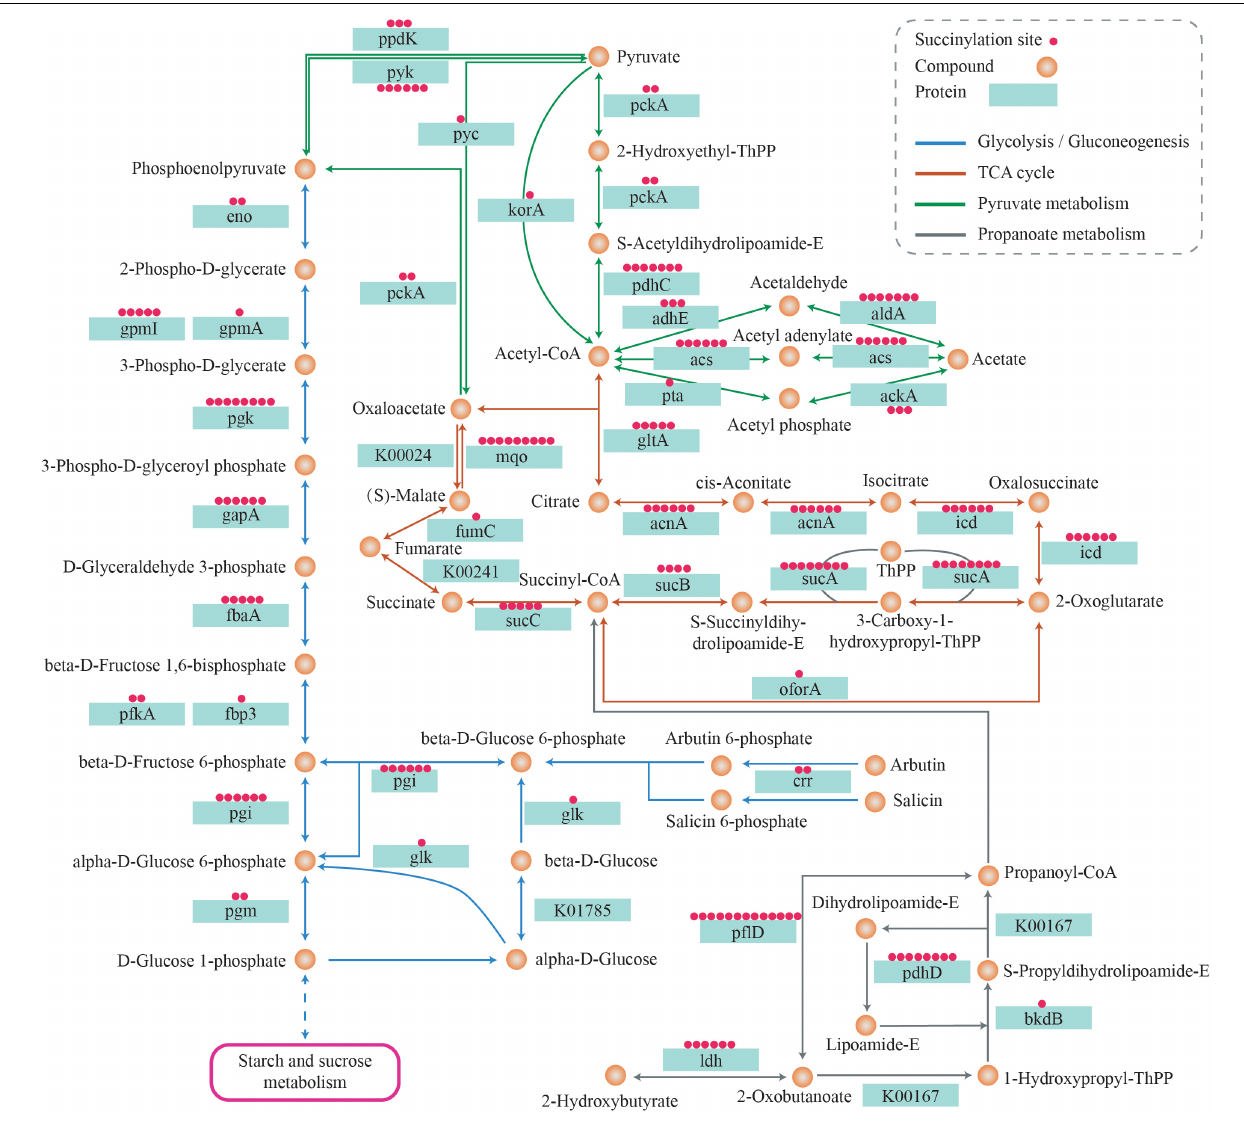
FIGURE 12 | Succinylated proteins related to metabolism